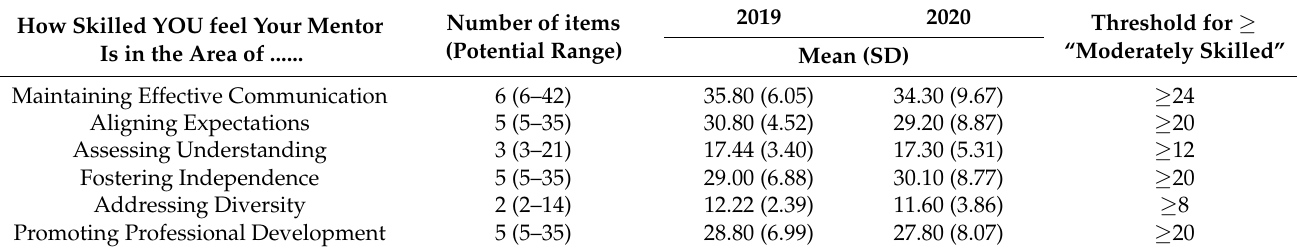
Table 4. Scholar (N = 10) Evaluation of Mentors (N = 11) † . How Skilled YOU feel Your Mentor Is in the Area of